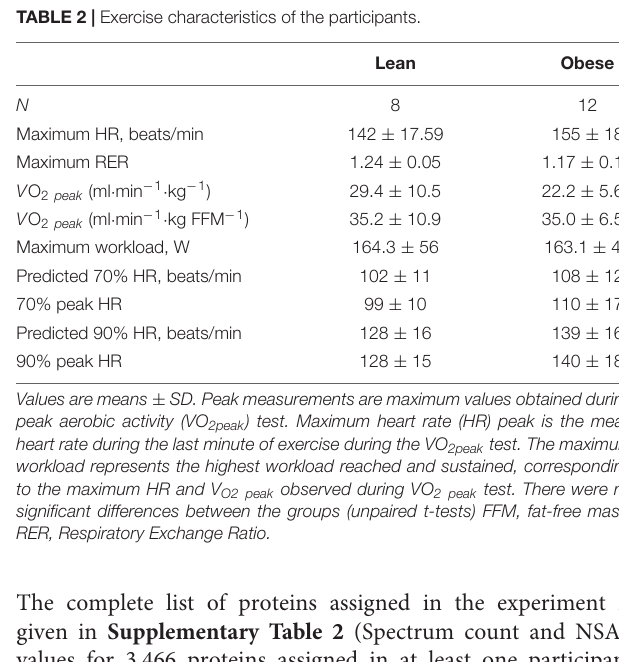
TABLE 2 | Exercise characteristics of the participants.